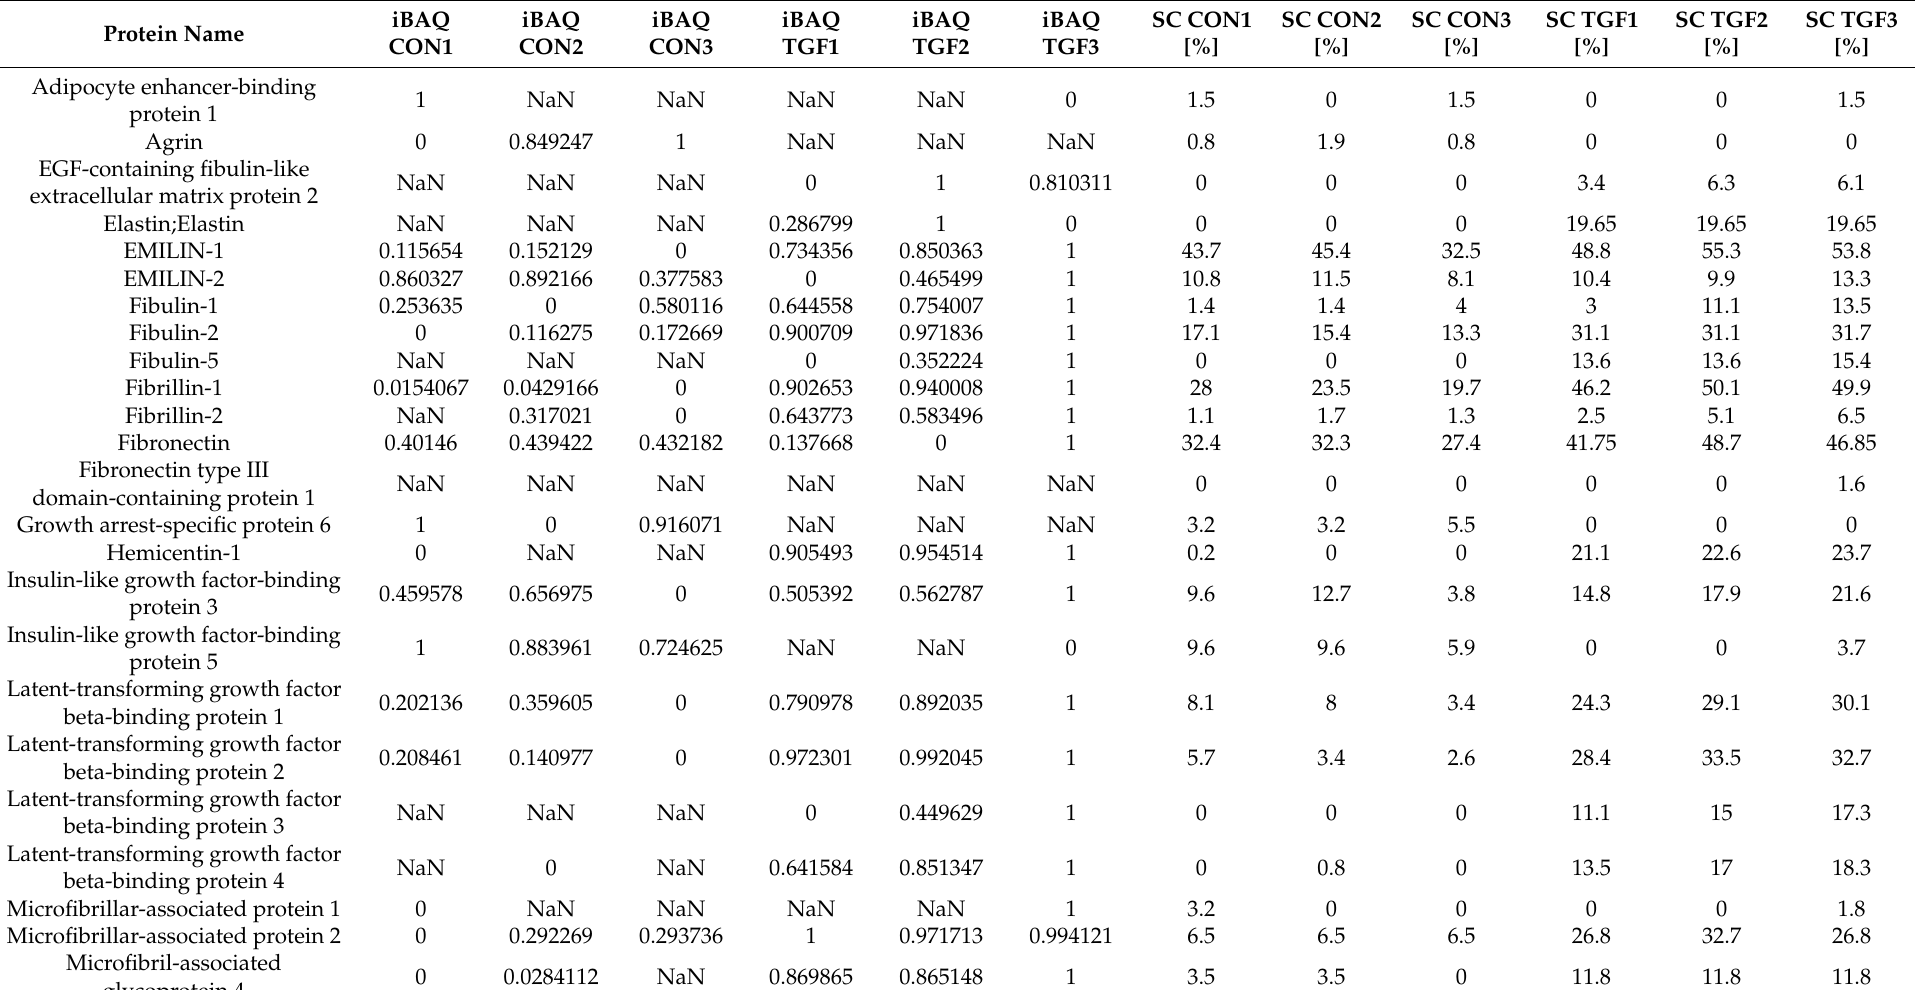
Table A1. ECM protein identifications found in the control and TGF β -1 treated cultured dermal fibroblasts. Each condition was measured in a triplicate. Control samples are labelled